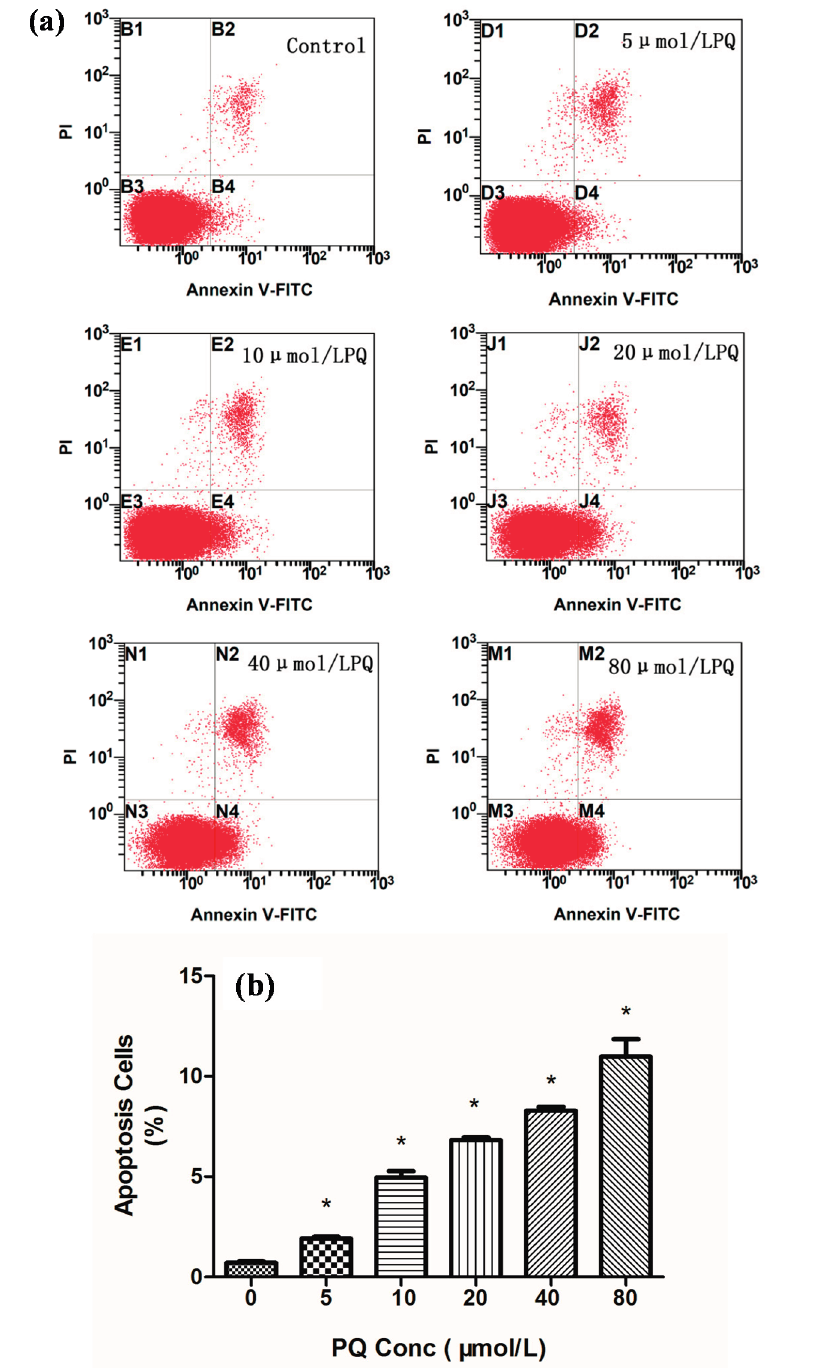
Figure 2. PQ-induced a dose-dependent increase of apoptosis shown in dot plot ( a ) and the percentage ( b ) in hNPCs. hNPCs were treated with PQ for 24 h and apoptotic cells were identified and quantified using the Annexin V-FITC apoptosis detection kit. Dot-plot ( a ) shows hNPCs staining with Annexin V-FITC versus propidium iodide (PI) resulting in distinct population. Cells staining with Annexin but without PI staining (lower right quadrant) can be considered as apoptotic cells and the percentage of apoptotic cells was calculated ( b ). * Indicate statistically significantly increase as compared to that in the control ( p < 0.05). n = 3 independent biological replicates for flow cytometric